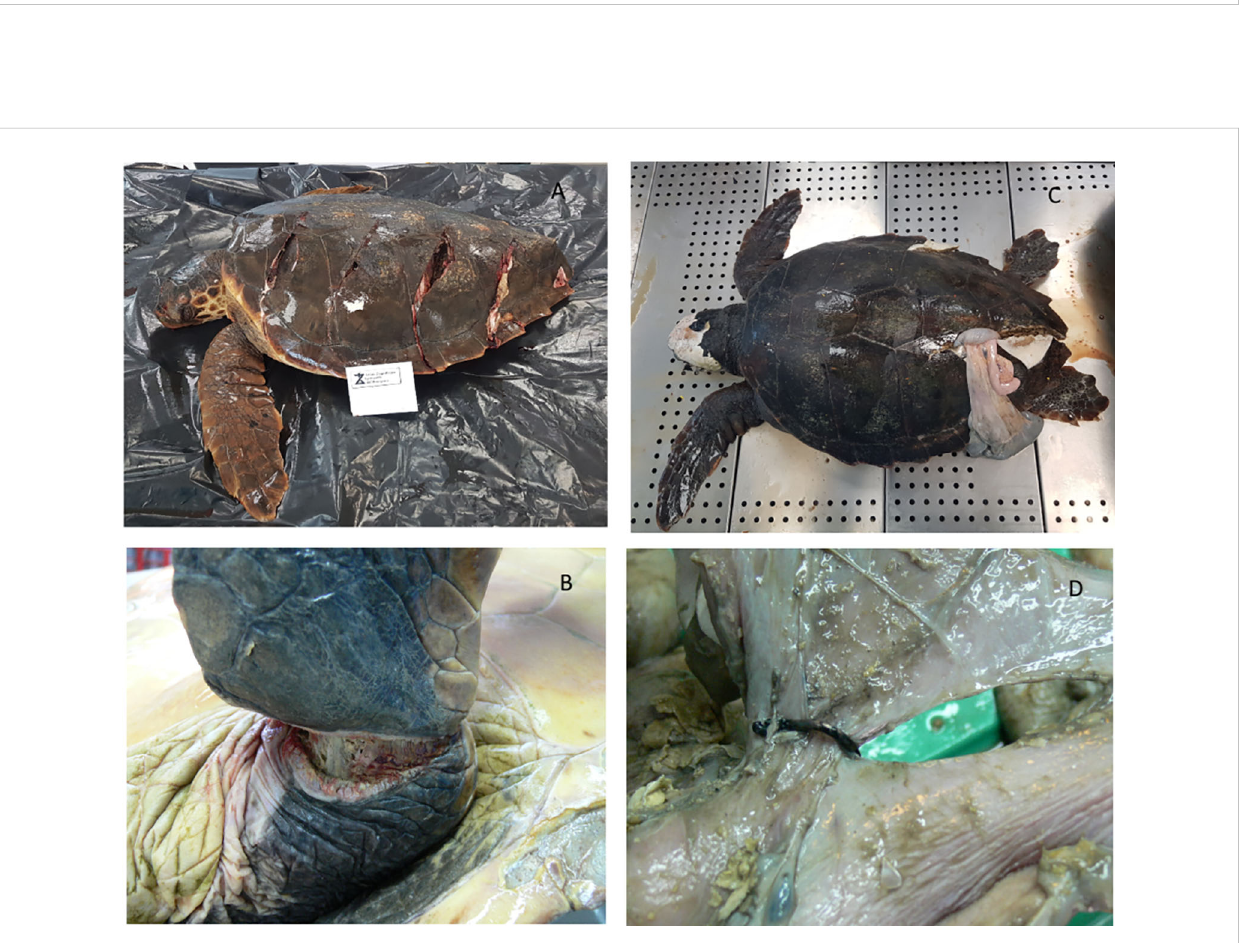
FIGURE 3 Animals with fatal wounds caused by anthropic impact. (A) Carapace fracture probably caused by the propeller of a boat. (B) Laceration at the basis of the fi n likely determined by the entanglement of the animal in a net or a line. (C) Carapace fracture (with organ leakage) probably caused by a collision with a boat. (D) Laceration of the intestine caused by hook ingestion.